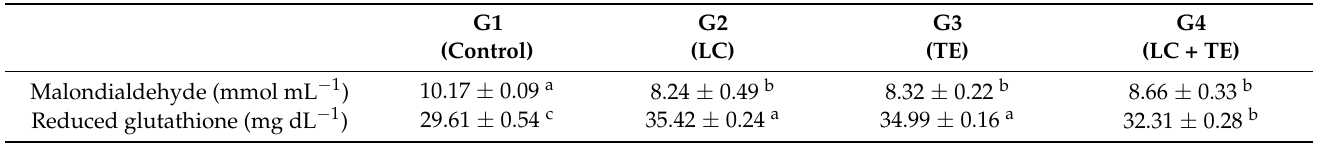
G1 G2 G3 G4 (Control) (LC) (TE) (LC + TE)